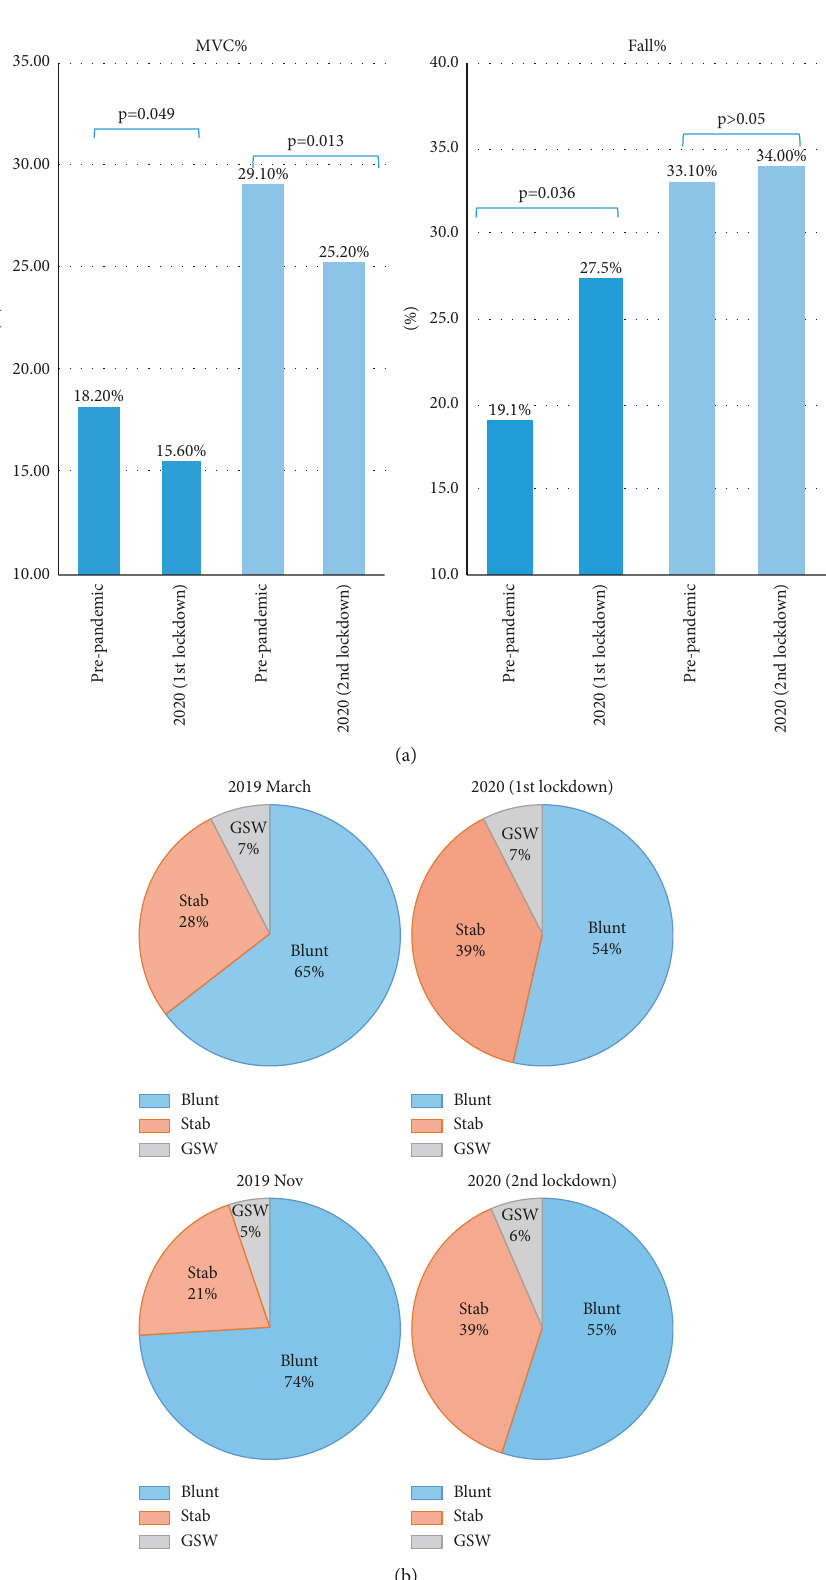
Figure 3: The breakdown of trauma types comparison in our level 1 trauma center in two COVID-19 lockdown periods in 2020 versus prepandemic periods in 2019. (a) The percentage of MVC trauma cases and falls. (b) The percentage of stabbing, blunt trauma, and GSW cases. Multiple comparisons were made using χ 2 test (chi-square analysis). p value refers to a relative portion of MVC/Fall cases to total CT